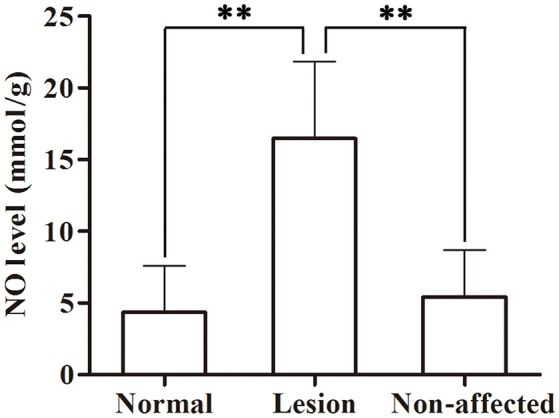
Skin tissue NO levels in a swine DCS model. Tissues were sampled in the lesion and non-affected skin from 11 swine after a simulated air dive to 40 m for 35 min with an 11 min decompression. Normal skin samples were collected pre-dive. NO was detected by ELISA. Values are presented as mean ± SD (**P < 0.01).